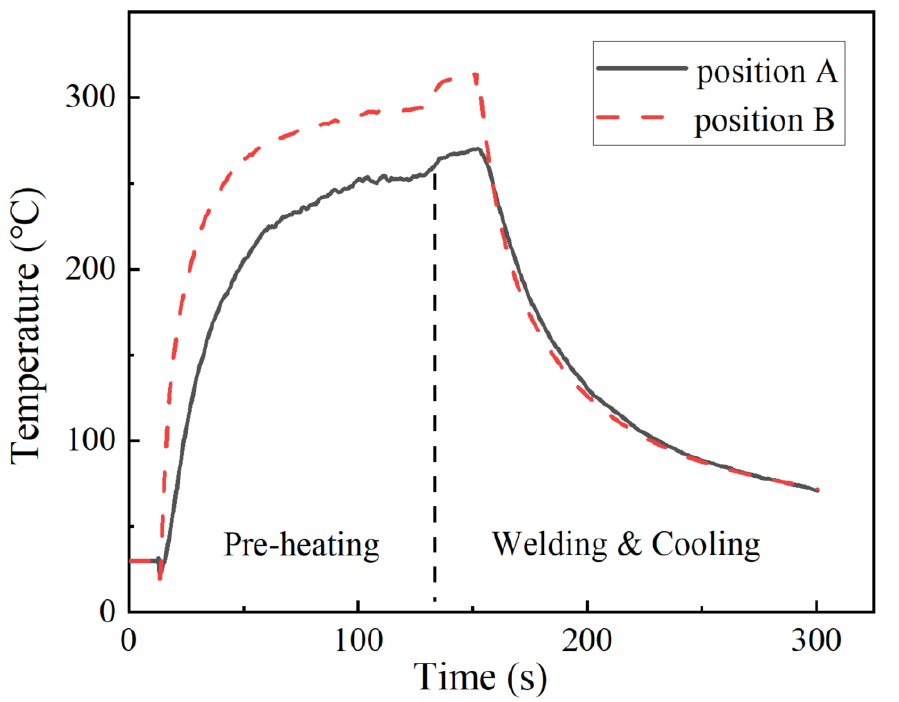
Figure 3. Temperature curves during the hot pressing process.